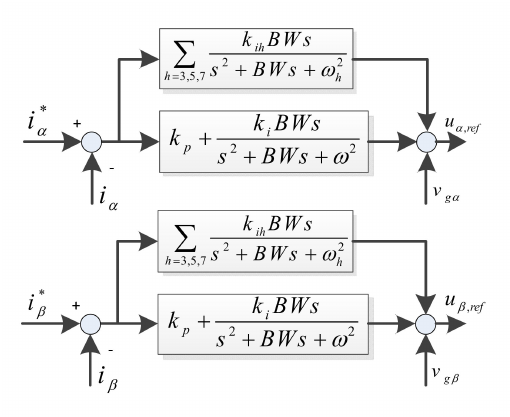
Figure 9. Standard non-ideal PR controller with harmonic compensators in the stationary reference frame.